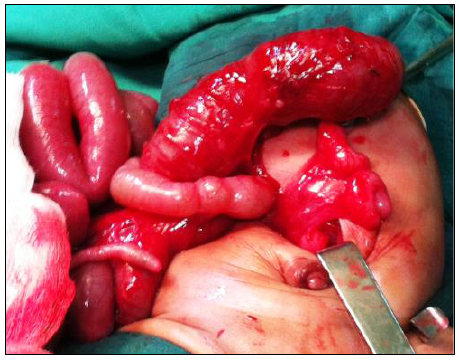
Figure 1 : Showing blind ending transverse colon with multiple atresia of distal